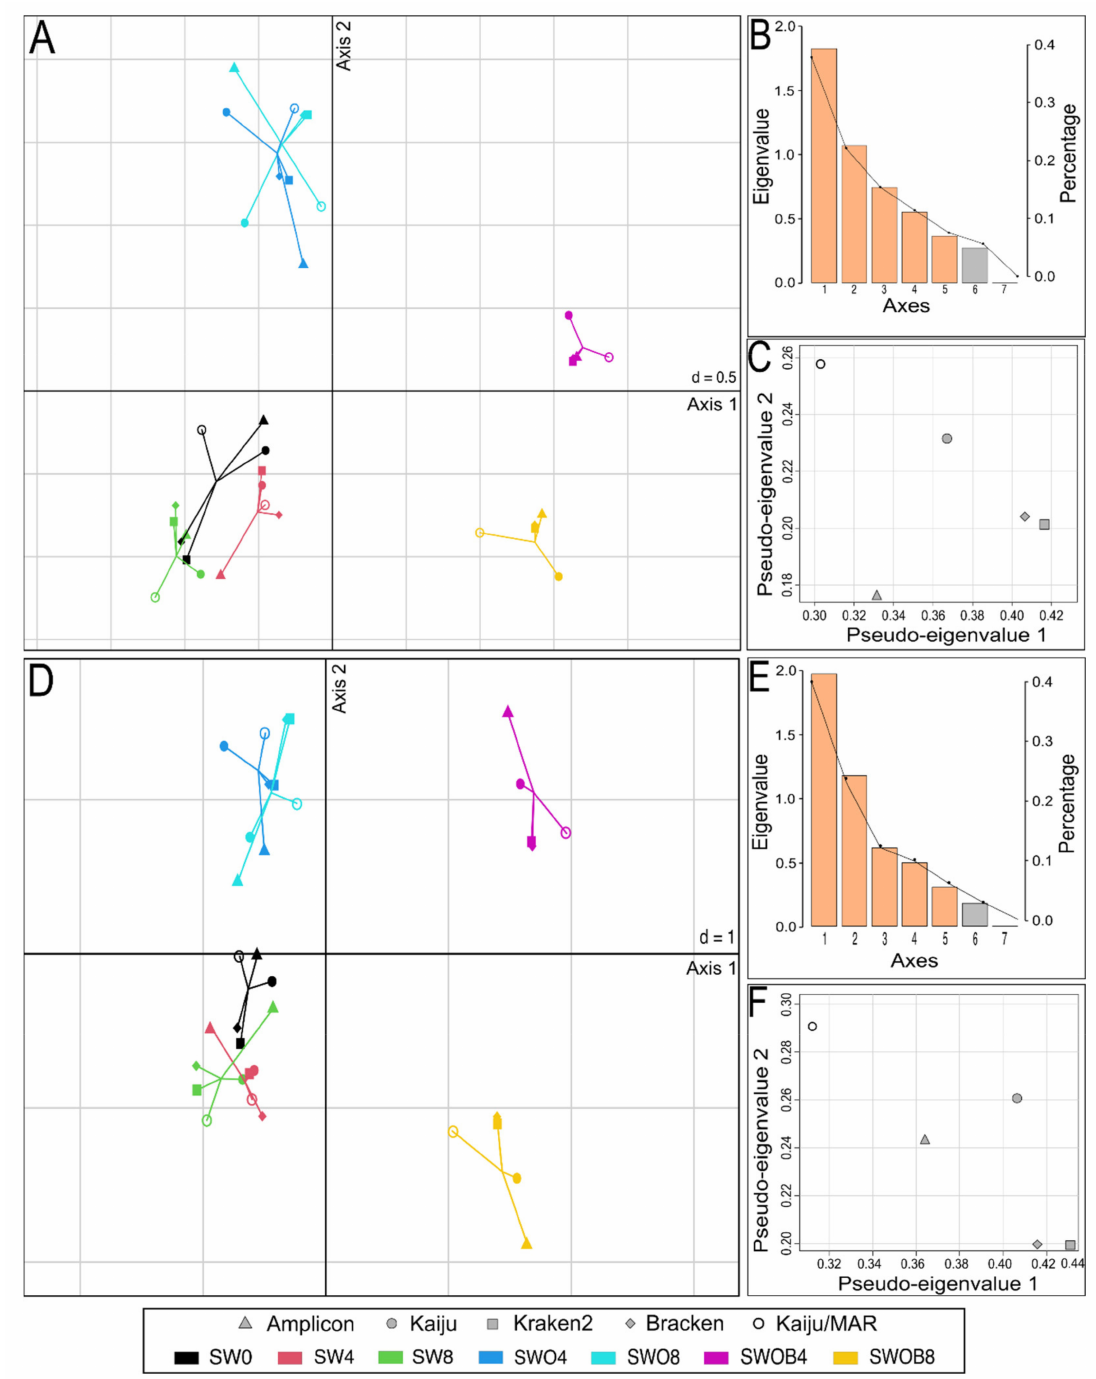
Figure 5. Multiple co-inertia analysis (MCIA) results based on five bacterial genera proportion datasets obtained with different taxonomic assignment methods (Kaiju with NCBI-nr database, Kaiju with MAR DB database, Kraken2 and Bracken with Standard Kraken2 database, and Amplicon-based sequencing with SILVA database) from seawater (SW), oil-contaminated seawater (SWO), and biostimulated oil-contaminated seawater (SWOB). The numbers in sample codes denote time in months. Subplots ( A – C ) depict MCIA results based on proportion data of the 50 predominant bacterial genera, and subplots ( D – F ) depict MCIA results based on proportion data of genera containing hydrocarbon-degrading organisms. Subplots ( A , D ) present the first two MCIA components in the sample space. Each sample is represented by a shape, where the five datasets for the sample are connected by lines to a center point (global score). ( B , E ) are Scree plots of absolute eigenvalues (bars) and the proportions of variance for the eigenvectors (line). ( C , F ) are data weighting graphs that show the pseudo-eigenvalue space of all datasets indicating how much variance of an eigenvalue is contributed by each